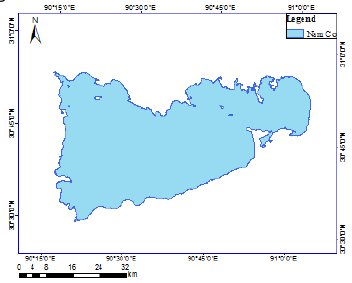
Figure 3. Geographical location of Nam Co